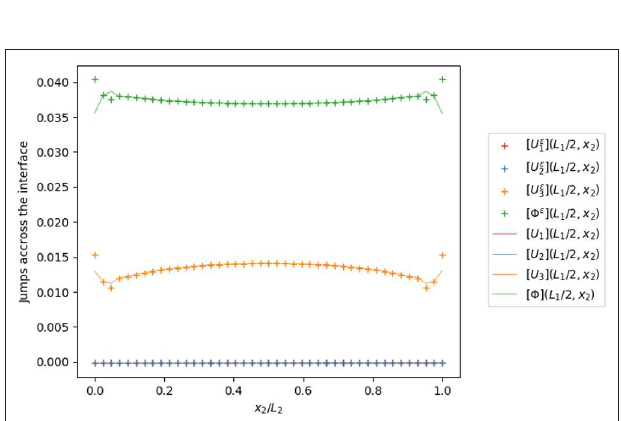
FIGURE 4 | Jumps of the displacement field and the electric potential across the interface on a line along the x 1 axis, with ε/ h = 0.1.